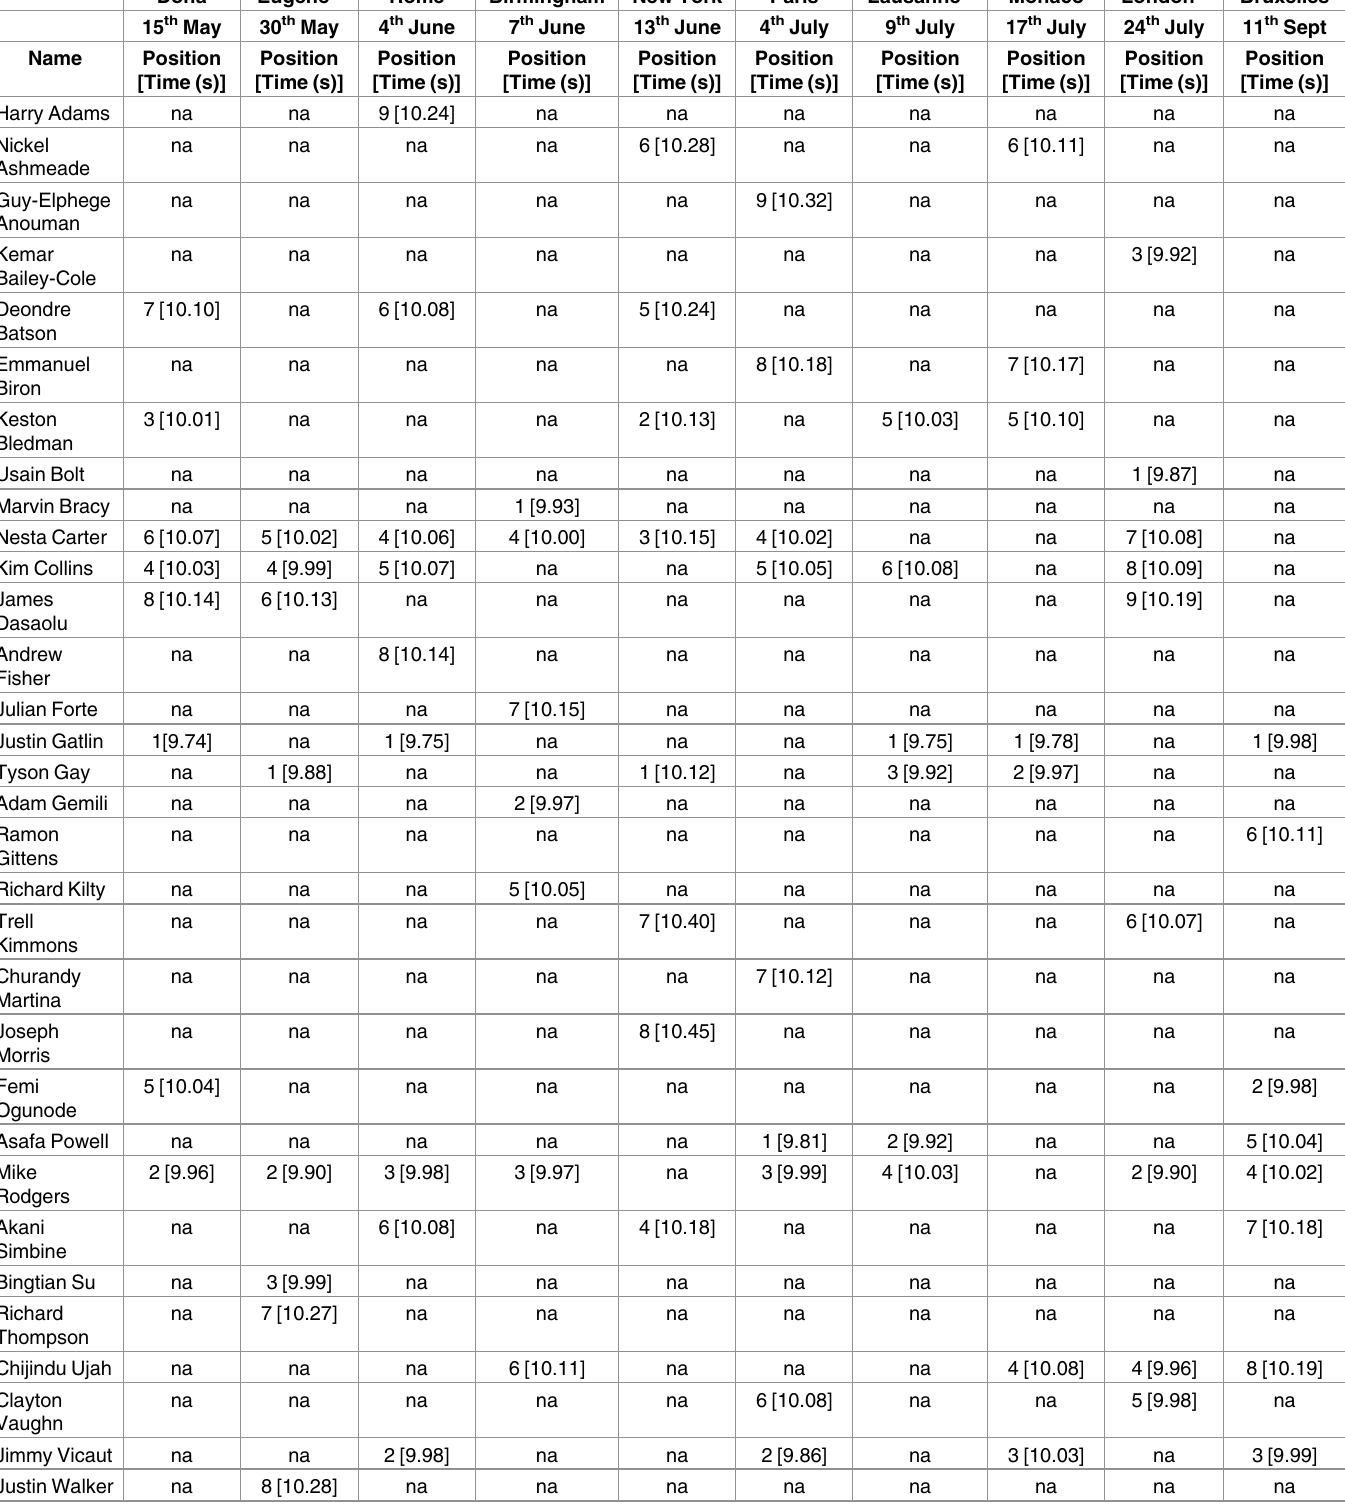
Table 1. The results of the ten male 100m raceslisted on the IAAF Diamond League web site.